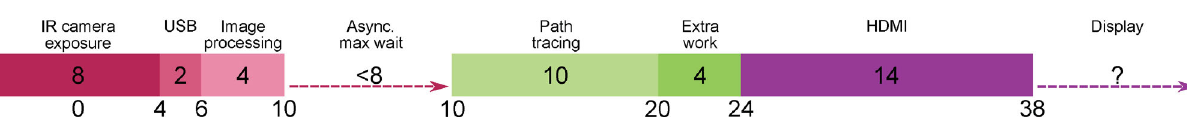
Fig. 7 Breakdown of the system latency in milliseconds. Best-case latency is approximately 38 ms. Worst-case latency is hard to determine, since we do not know all the internals of the HMD used. Moreover, green timing is the only one we can affect without changing the